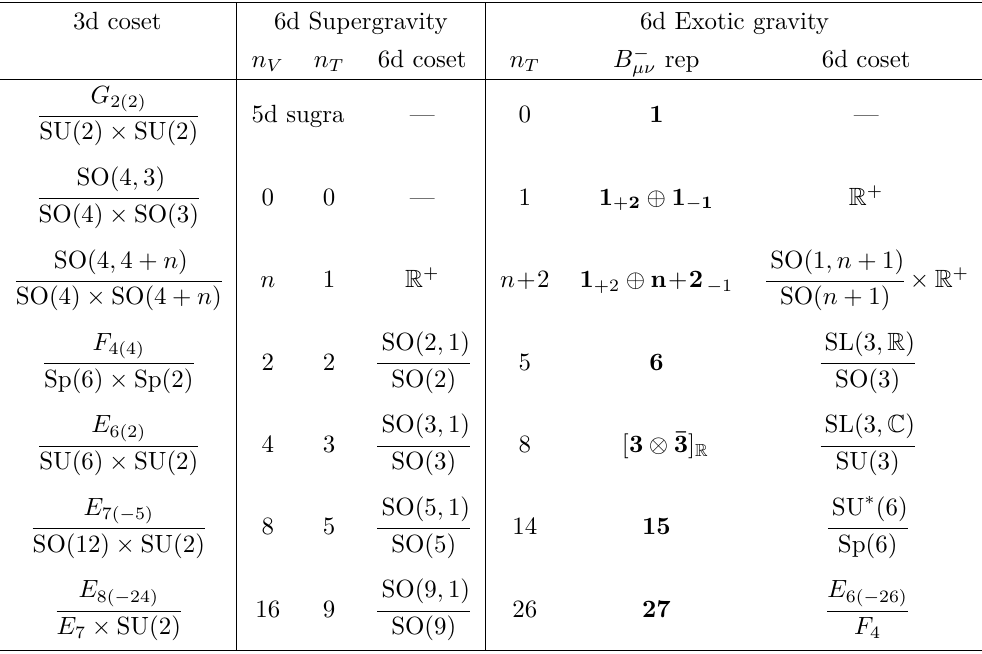
Table 3 . N = (1 , 0) supergravity and exotic supergravity theories and their duality